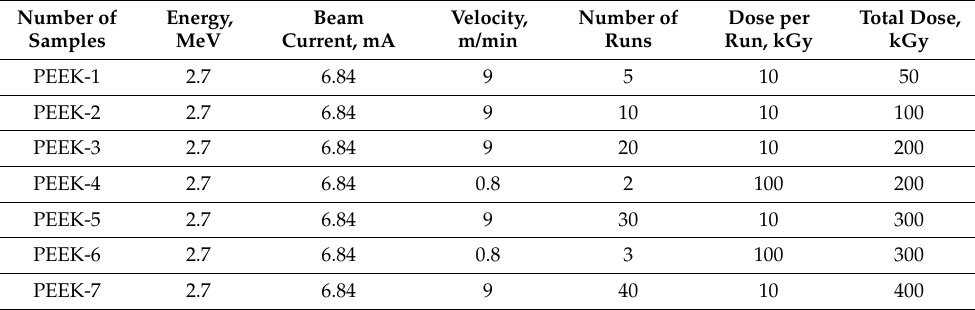
Table 1. Electron beam irradiation modes of PEEK samples at the ILU-10